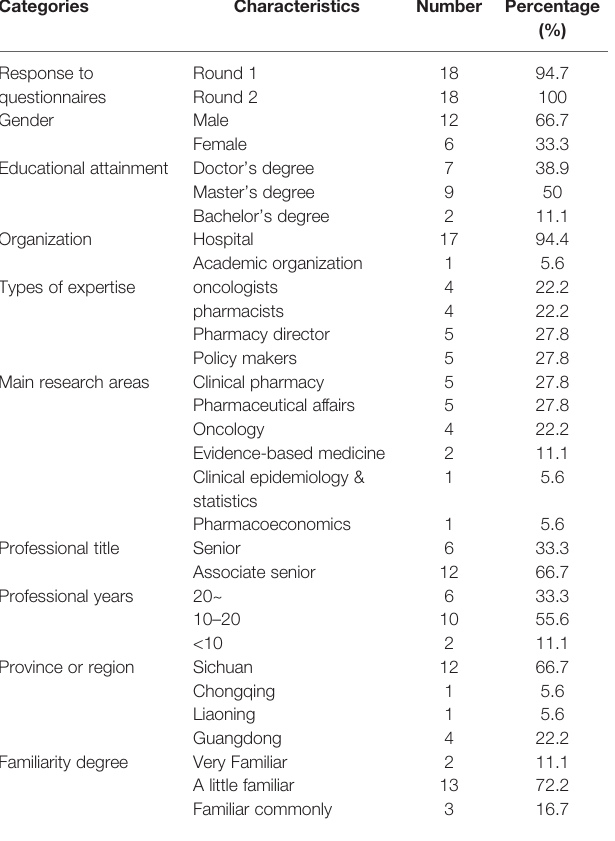
TABLE 1 | Characteristics of expert